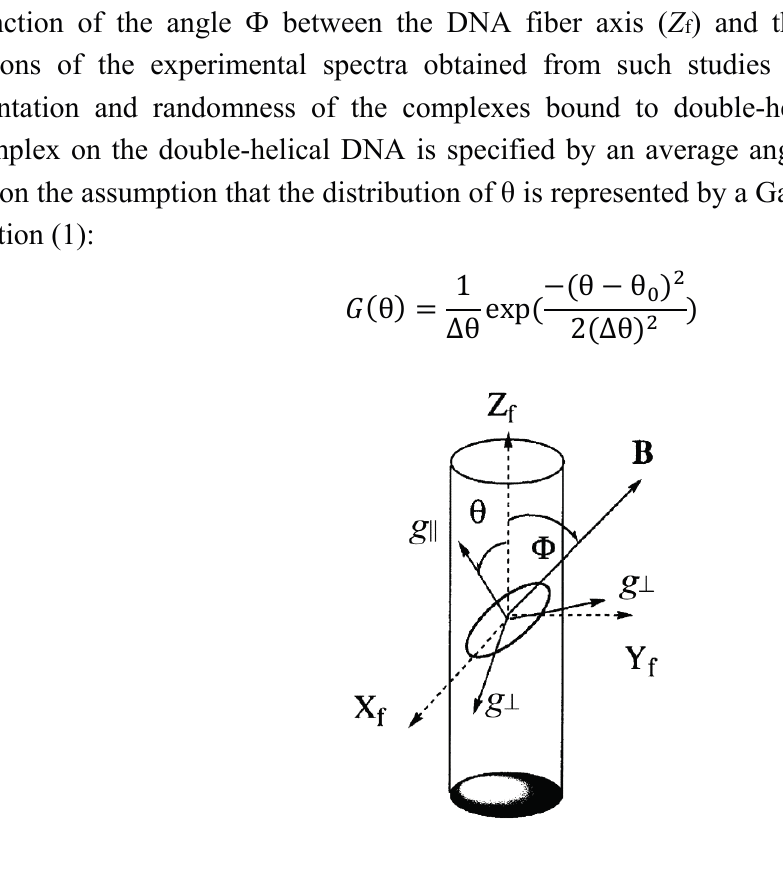
Figure 1. Coordinate systems: B , static magnetic field; (X f , Y f , Z f ), DNA-fiber axes; ( g || , g ⊥ ), g tensor axes; Ф , the angle between B and Z f ; θ , the angle between g || axis and Z f